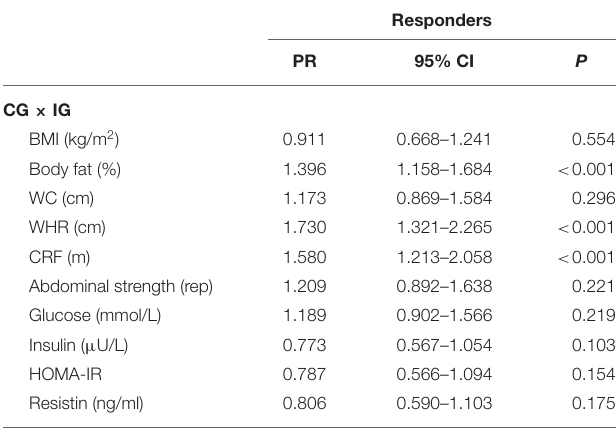
TABLE 3 | Differences in the prevalence of responders between IG and